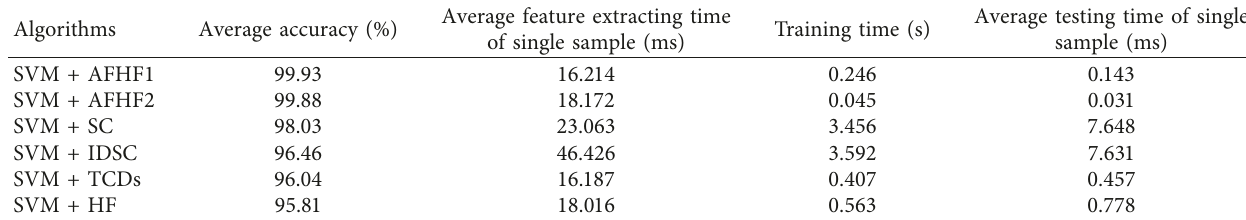
Figure 6: The experiment flowchart. Table 3: Experimental results on simulated shaft orbit dataset by